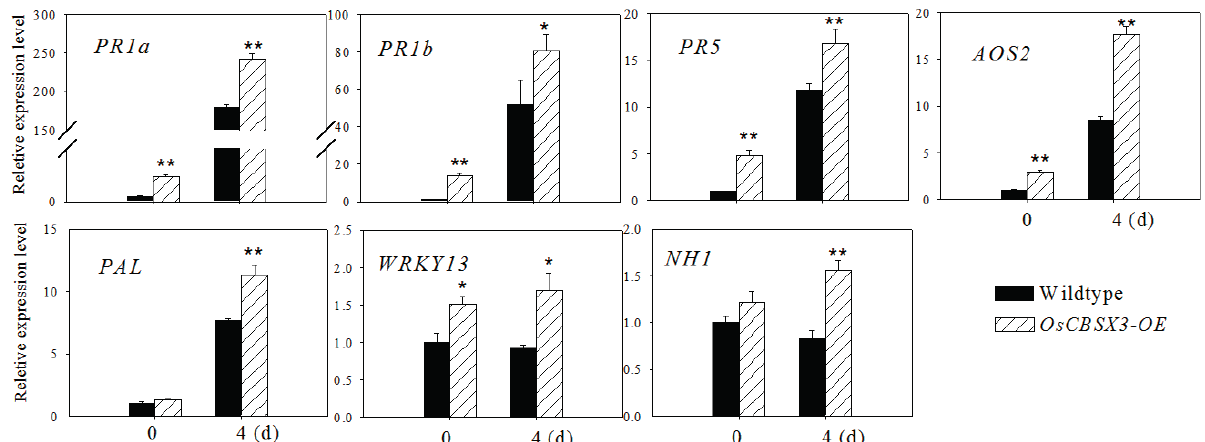
Figure 5. Quantitative PCR analysis of relative expression levels of pathogen-related genes in leaves of wildtype plants and OsCBSX3 over-expression lines at 0 and 4 dpi of M. oryzae strain guy11. Bars represent mean ± SE of three biological replicates. Asterisks indicate significant differences between the OsCBSX3-OE and wildtype plants in the same time point (Student–Newman–Keuls test, * p < 0.05 or ** p <